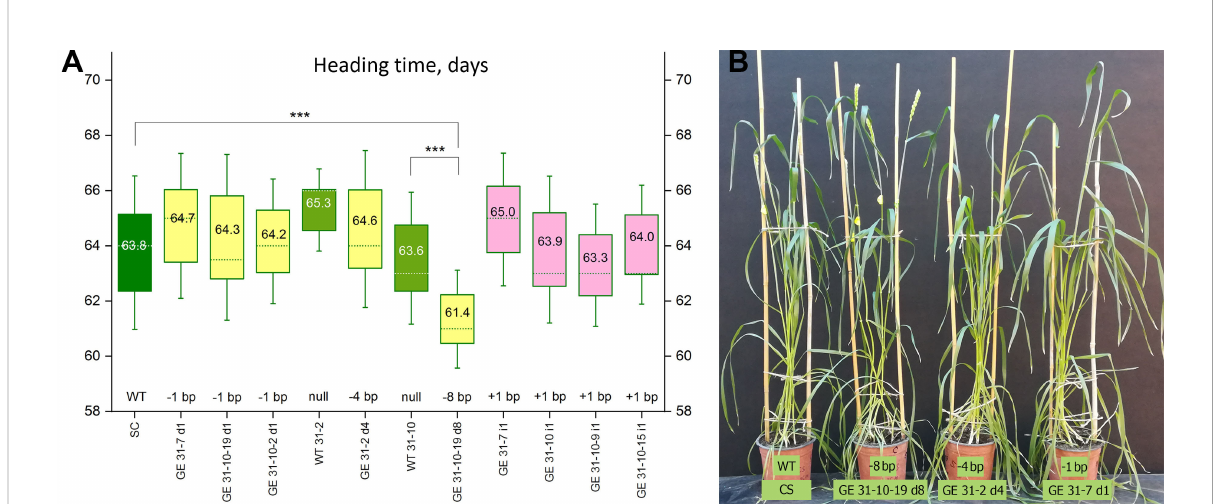
FIGURE 3 Characterization of the growth habit of genome-edited wheat lines. (A) Heading dates of the plants carrying various types of CRISPR/Cas9- induced homozygous mutations in the target region of vrn-A1 promoter; plants carrying the wild-type allele of vrn-A1 ( ‘ Chinese Spring ’ and two null siblings) are indicated in green; GE lines with base pair deletions are shown in yellow, GE lines with base pair insertions are shown in pink. Heading time values were compared through ordinary one-way ANOVA test, and signi fi cant differences between the lines are shown according to Turkey ’ s multiple range test (*** p < 0.001). (B) The growth habit of the plants carrying the wild-type allele of vrn-A1 (WT, ‘ Chinese Spring ’ ) and three lines carrying homozygous alleles of vrn-A1 with various types of nucleotide deletions. The experiment was performed